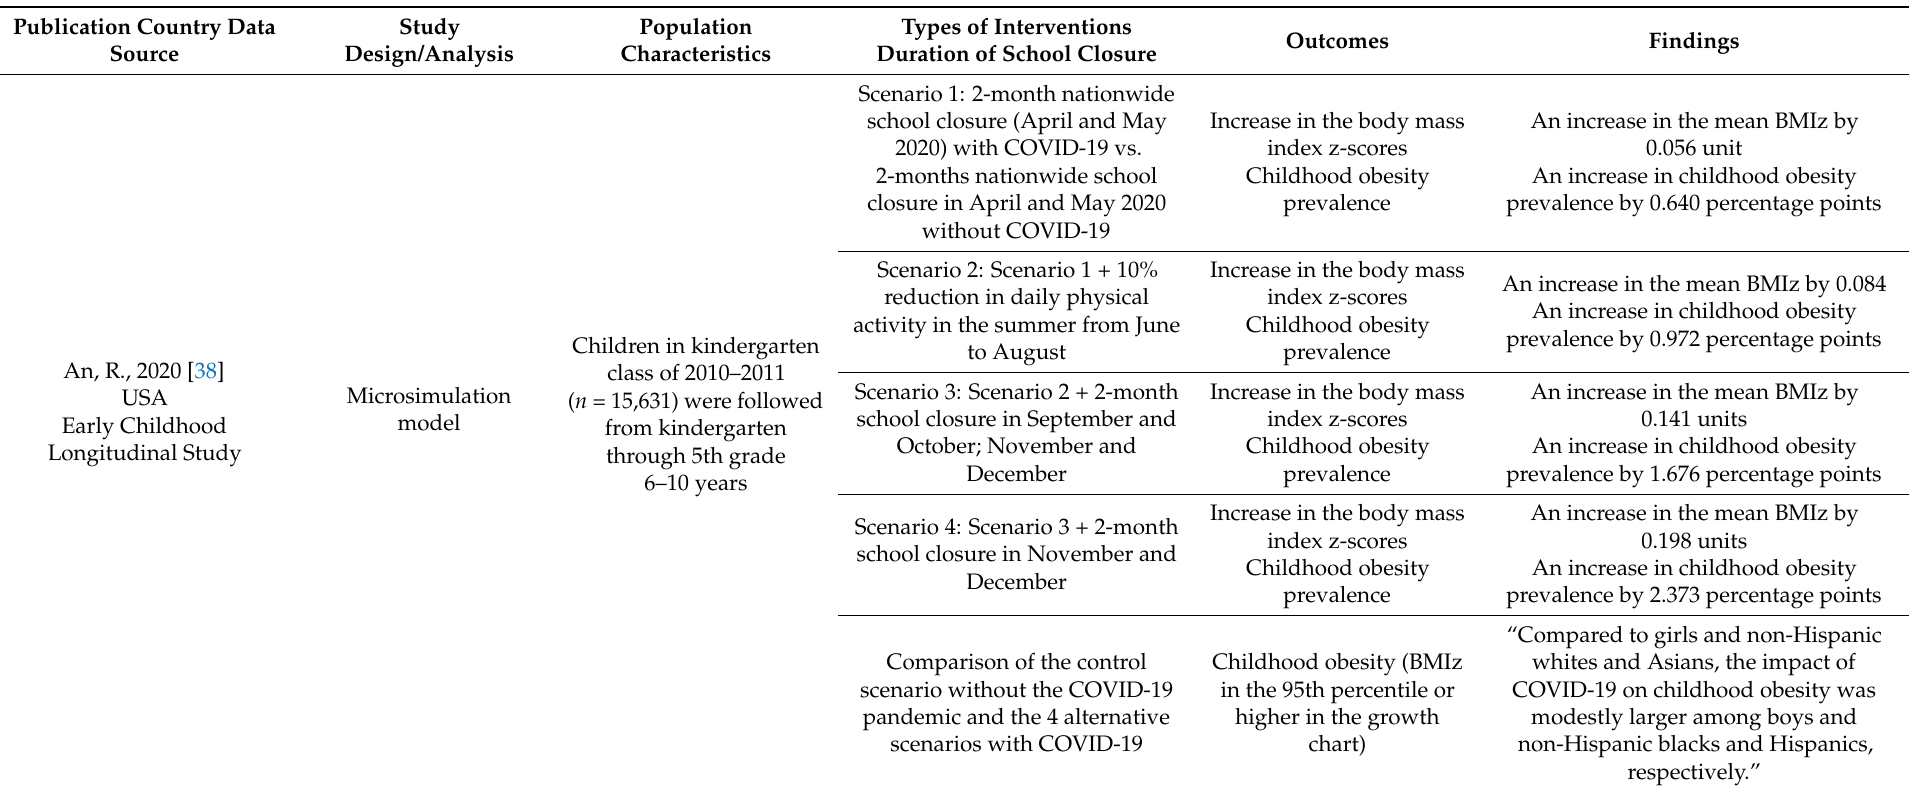
Table 1. Characteristics of the included primary studies on the impact of school closure on child and adolescent